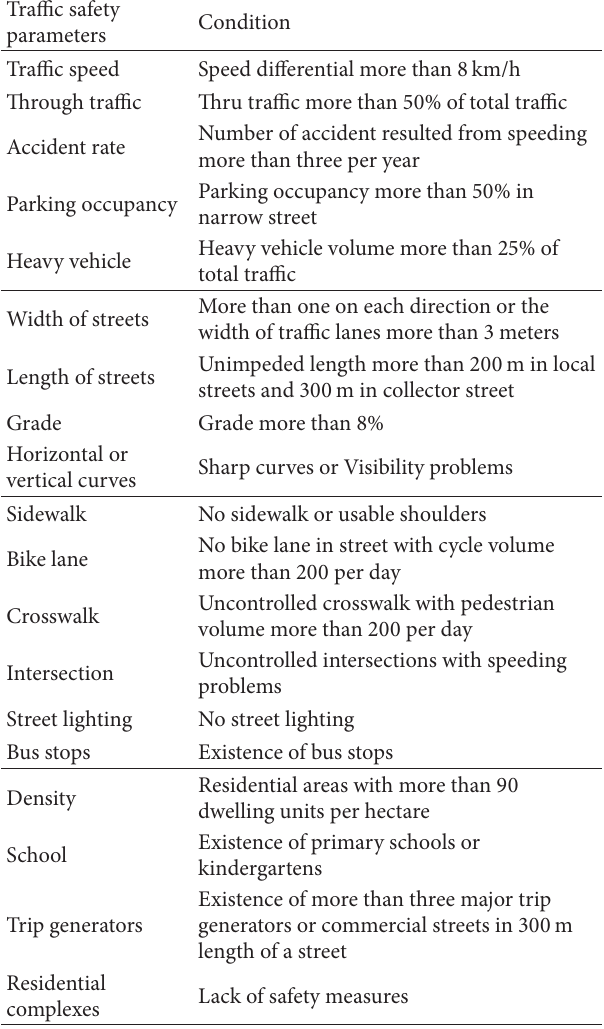
Table 4: Conditions of traffic safety